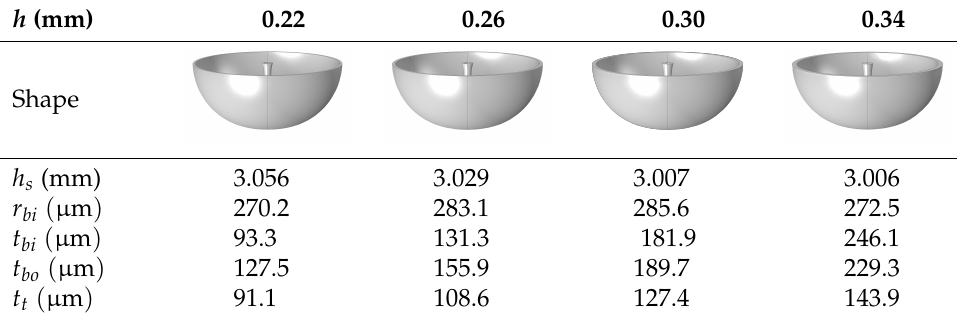
Table 6. Shape and key shape parameters of microhemispherical shells at different thicknesses of device